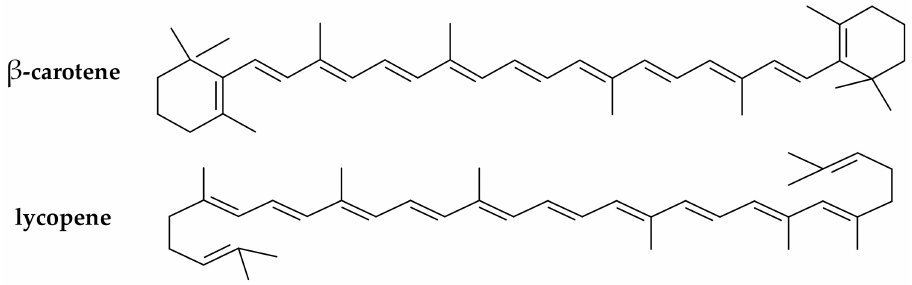
Figure 3. Chemical structure of the main provitamin A carotenes ( β -carotene,